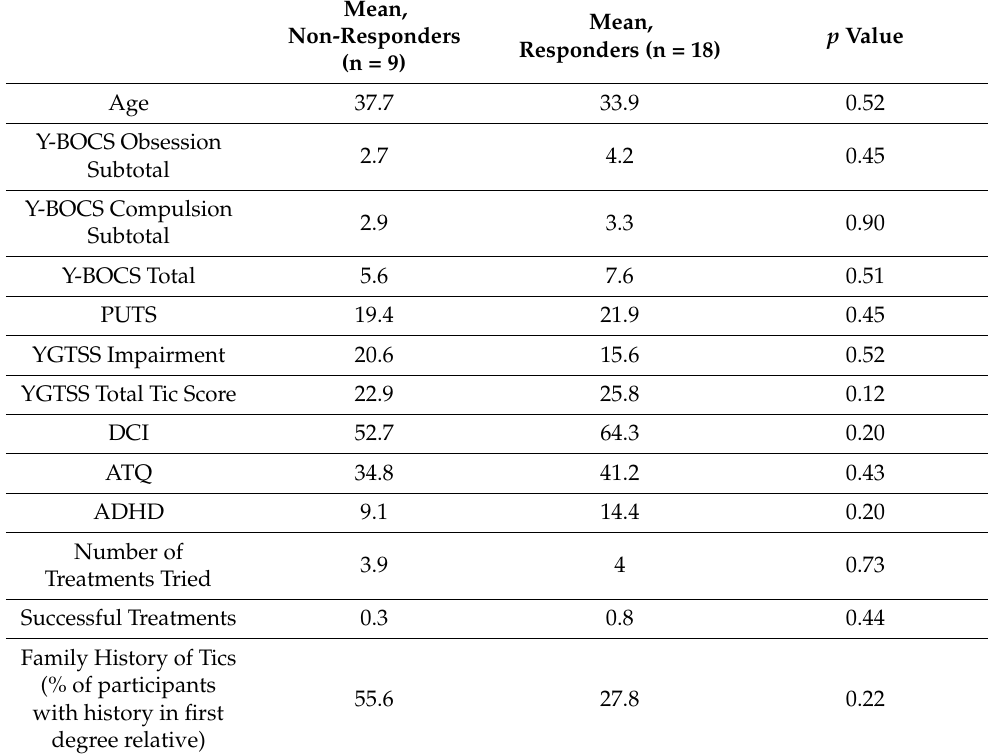
Table 3. Responders